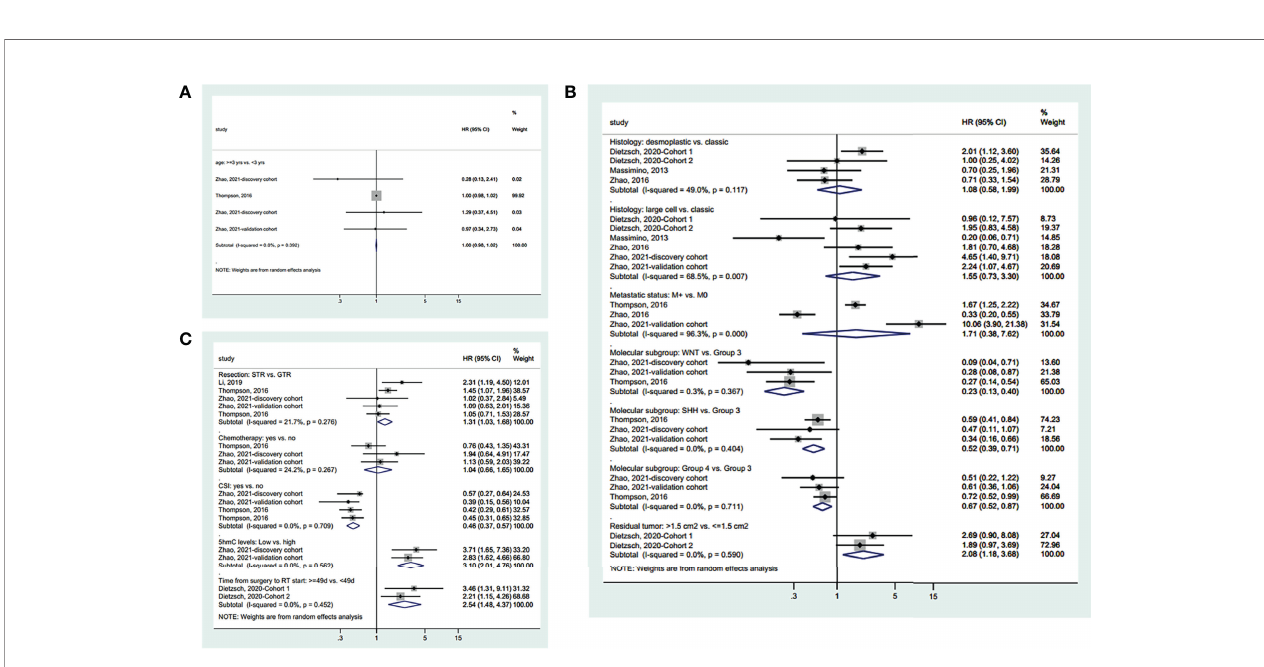
FIGURE 3 | Forest plots of the prognostic factors and progression-free survival (PFS). (A) Demographic characteristics. (B) Clinical characteristics. (C) Treatment